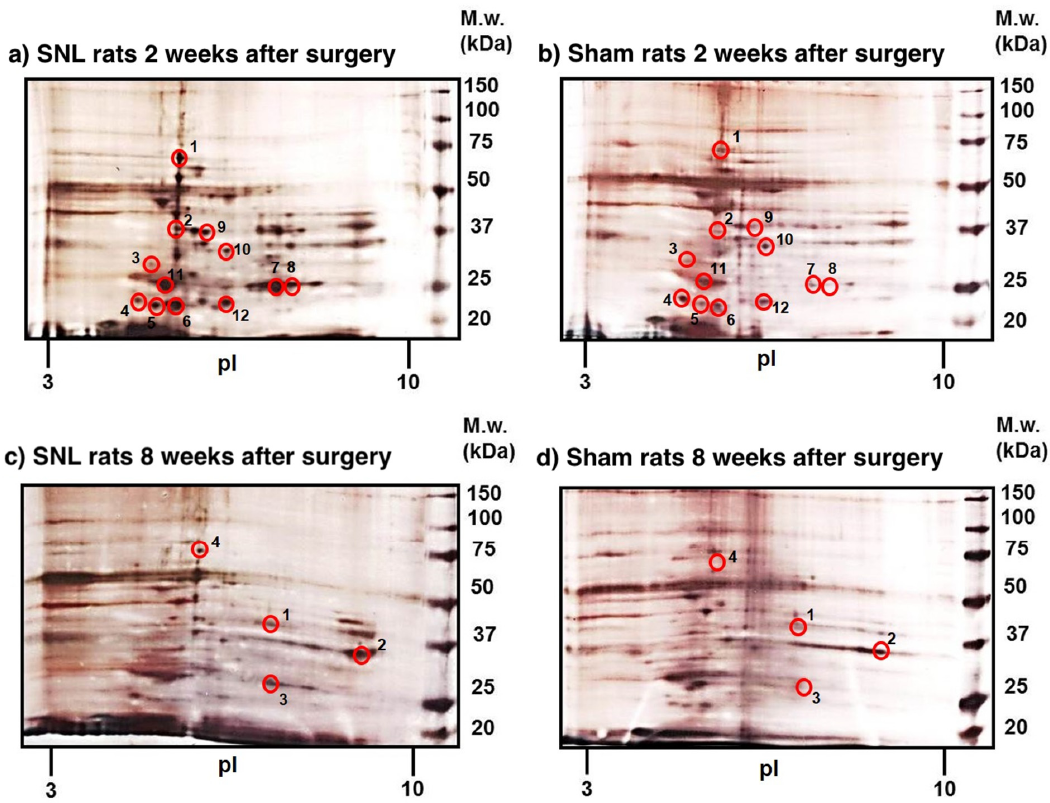
Figure 2. Representative 2D gel maps stained by silver. PNS fractions were isolated from mPFC of rats 2 weeks ( a,b ) and 8 weeks ( c,d ) after ( a,c ) SNL or ( b,d ) sham surgery. PNS fractions (250 µg of protein) were resolved by 2D-ELFO and stained by ProteoSilver TM Silver Stain Kit. The differences between SNL and sham-operated rat protein maps were evaluated by PDQuest TM software (Bio-Rad, version 8.0.1). Significantly altered protein spots ( p < 0.05) are marked with red circles (short-term effect: 1–12; long-term effect: 1–4). The spots cut out of the gels were analyzed by LC–MS/MS (two samples per spot). Table 1. LC–MS/MS analysis of altered protein spots in PNS fractions isolated from mPFC of SNL versus sham-operated rats 2 weeks after the surgery. The complete list of exclusive unique peptides is presented in Table S1.